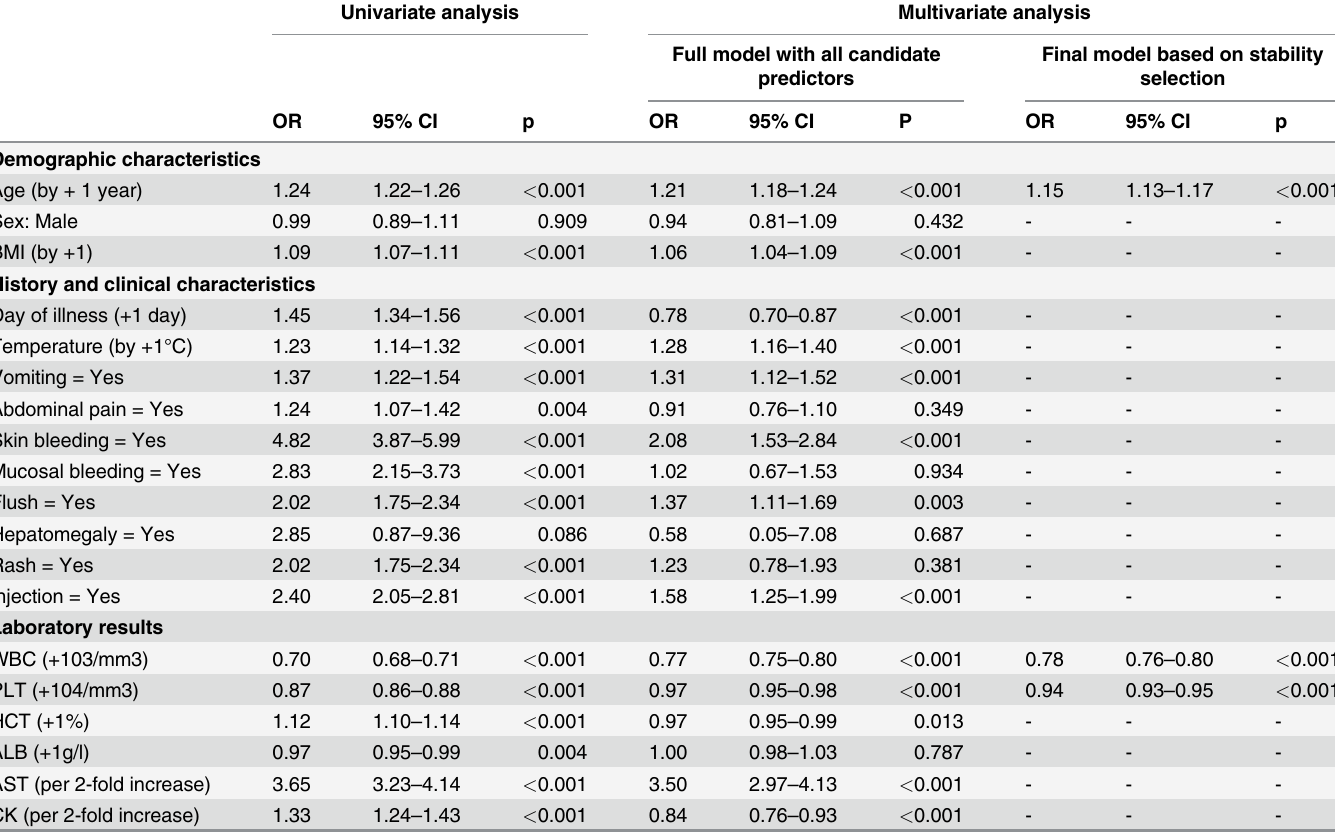
Table 3. Univariate and multivariate analysis of candidate predictors of laboratory-confirmed